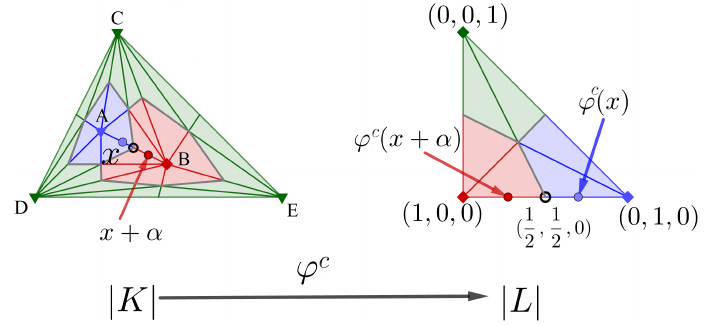
Figure 5. An adversarial example x for the simplicial-map neural network N ϕ : | K | → | L |